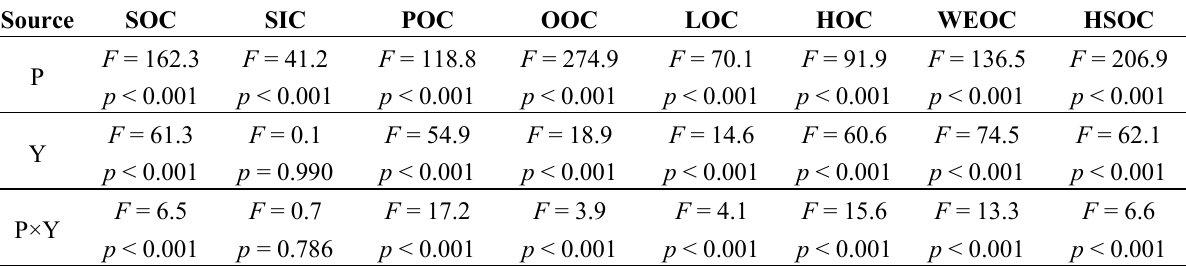
Table 5. Two way repeated measures ANOVA results for planting treatment (P) and year (Y), on the stock of soil organic carbon (SOC), soil inorganic carbon (SIC), particulate (POC), oxidizable (OOC), light fraction (LOC), heavy fraction (HOC), water extractable (WEOC) and hot water soluble (HSOC) organic carbon. Results were derived from the surface layer (to 20 cm). Degrees of freedom for planting treatment and year were F 4,40 , respectively, and F 16,40 for their